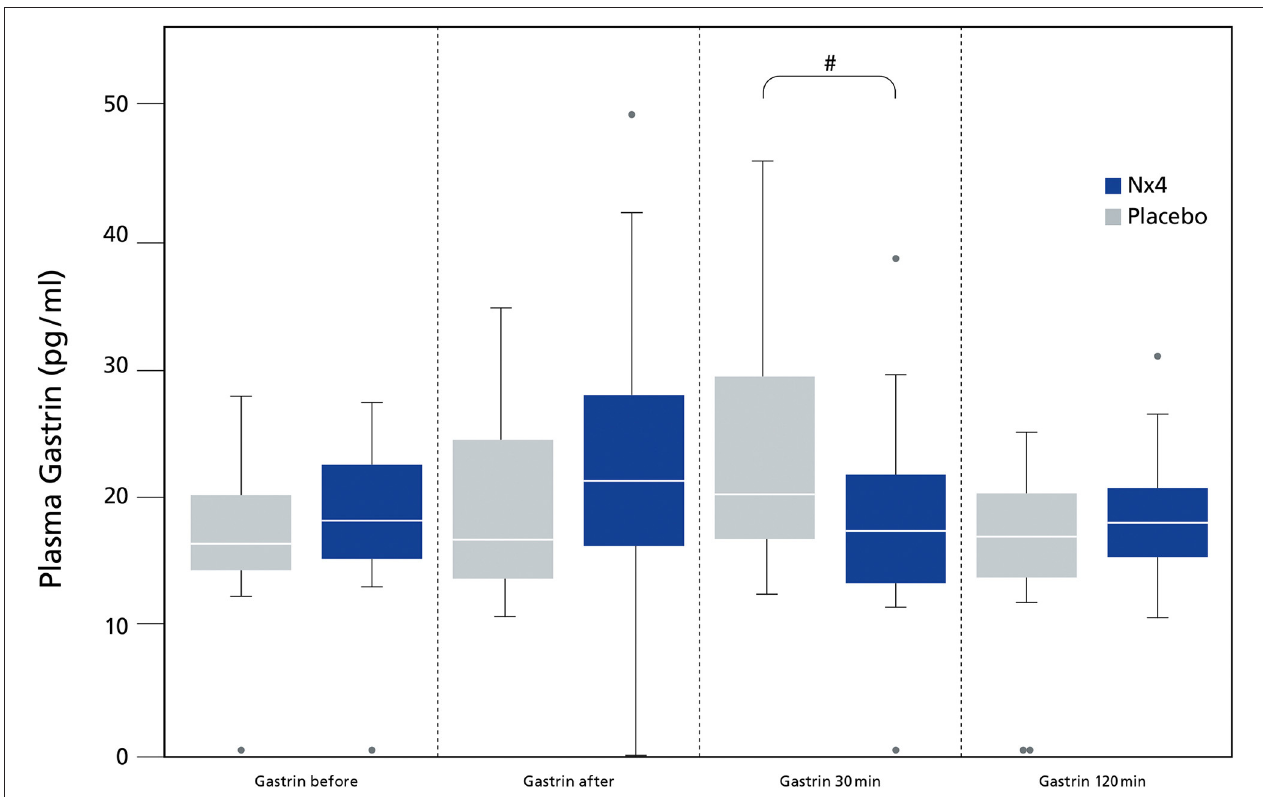
FIGURE 3 | Comparing plasma gastrin (pg/ml) between dogs receiving Nx4 or Placebo at different time points. The data ( n = 45), with 23 dogs in the Nx4 group and 22 dogs in the placebo group are displayed as boxplot showing the first (25%), the median (50%), and the third quartile (75%). The whiskers are displaying values within 1.5 times the IQR. Outliers are plotted as individual points. # p =